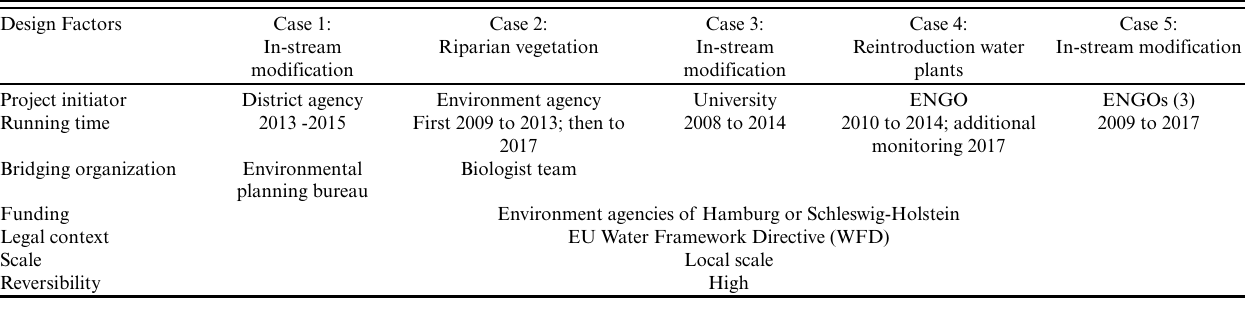
Table 2 . Features of case